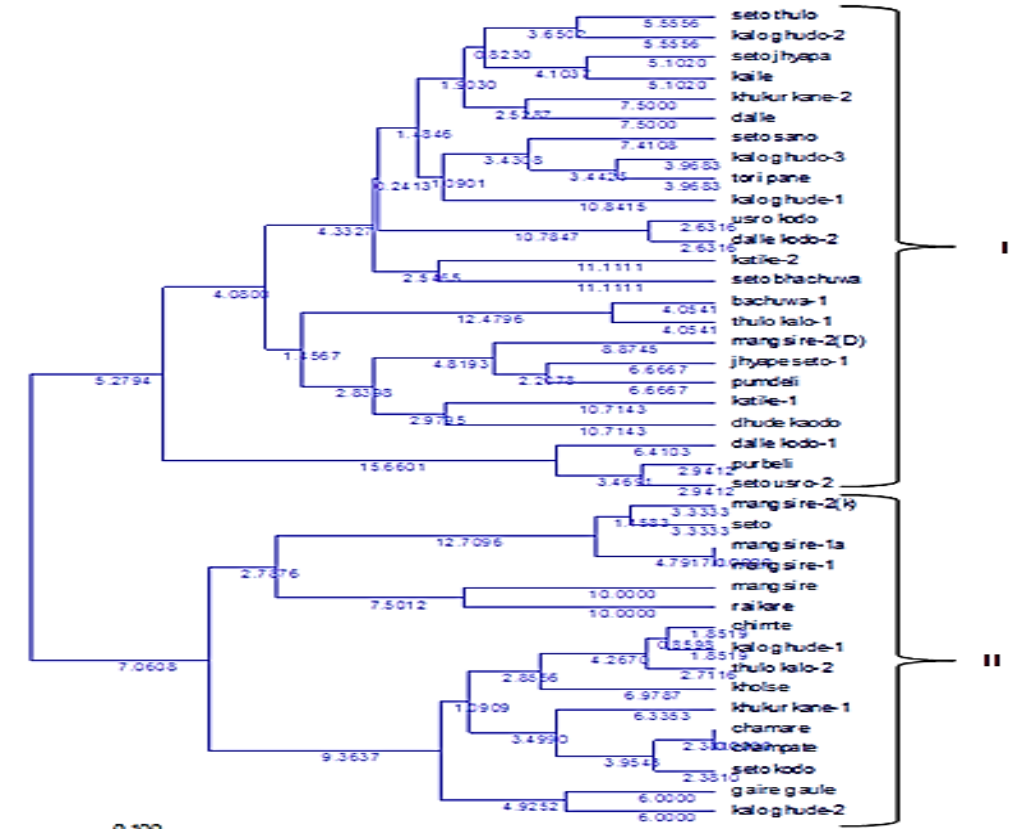
Figure 6. Dendrogram of 40 finger millet landraces using UPGMA methods with bootstrap of 1000 replications based on Nei’s genetic distance estimated from five SSR markers